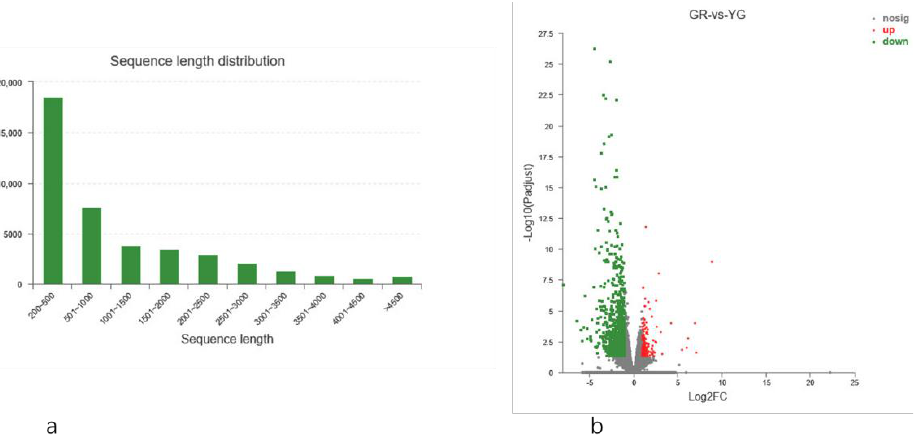
Figure 5. ( a ) Length distribution of transcripts; ( b ) volcano plot of DEGs. GR stand for the green region of the leaf and YG stands for the yellow-green region of the leaf.